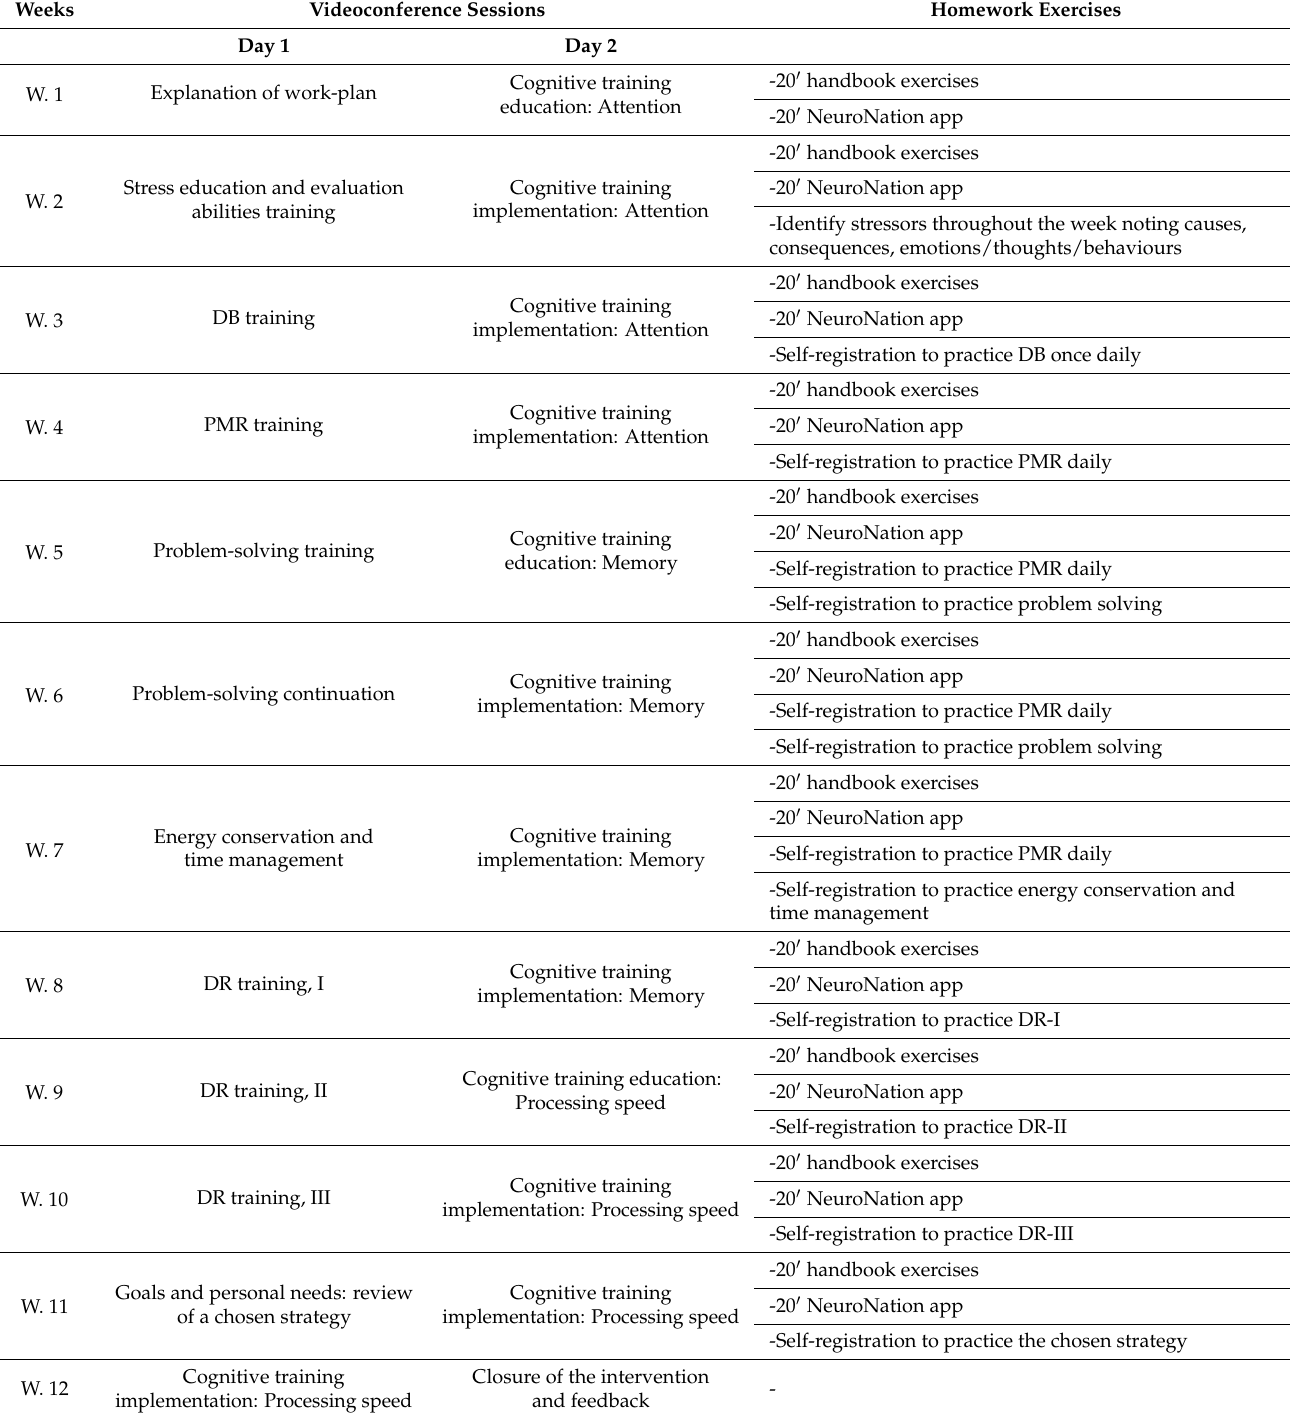
Table 1. Description of the e-OTCAT program in